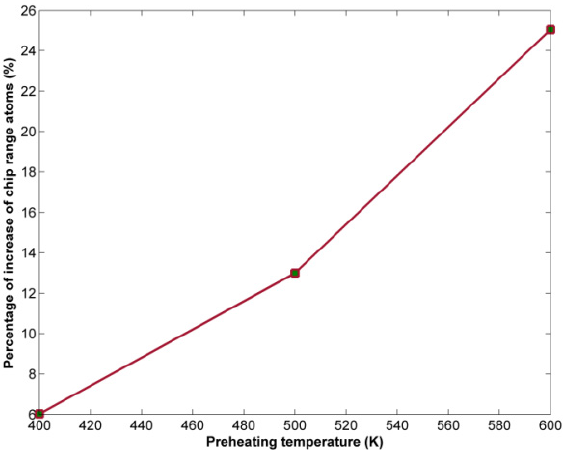
Figure 13. Variation of chip range atoms percentage of increase with respect to preheating temper- ature.